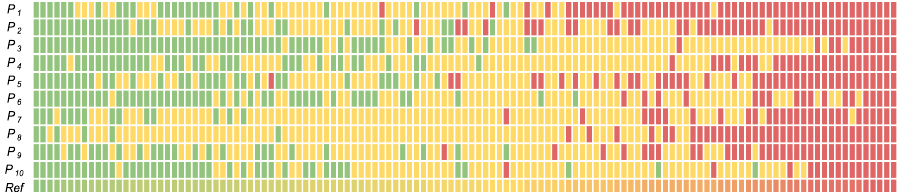
Fig. 10 Distribution of the nuclear pleomorphism scores of the pathologists and of the average (reference) scores of the pathologists in the ROI-study. The rows correspond to the pathologists, f P g g 10 , except for the last row that corresponds to the average scores of the g ¼ 1 pathologists, which we used as reference scores in our learning setup. Each column is one of the 125 queries in the ROI-study. The colors green, yellow and red correspond to the scores of 1, 2 and 3 of the pathologists, respectively. The queries are sorted by the average scores, from left to right in increasing order, denoted by the color hues of green, yellow and red, corresponding to the increasing severity of the